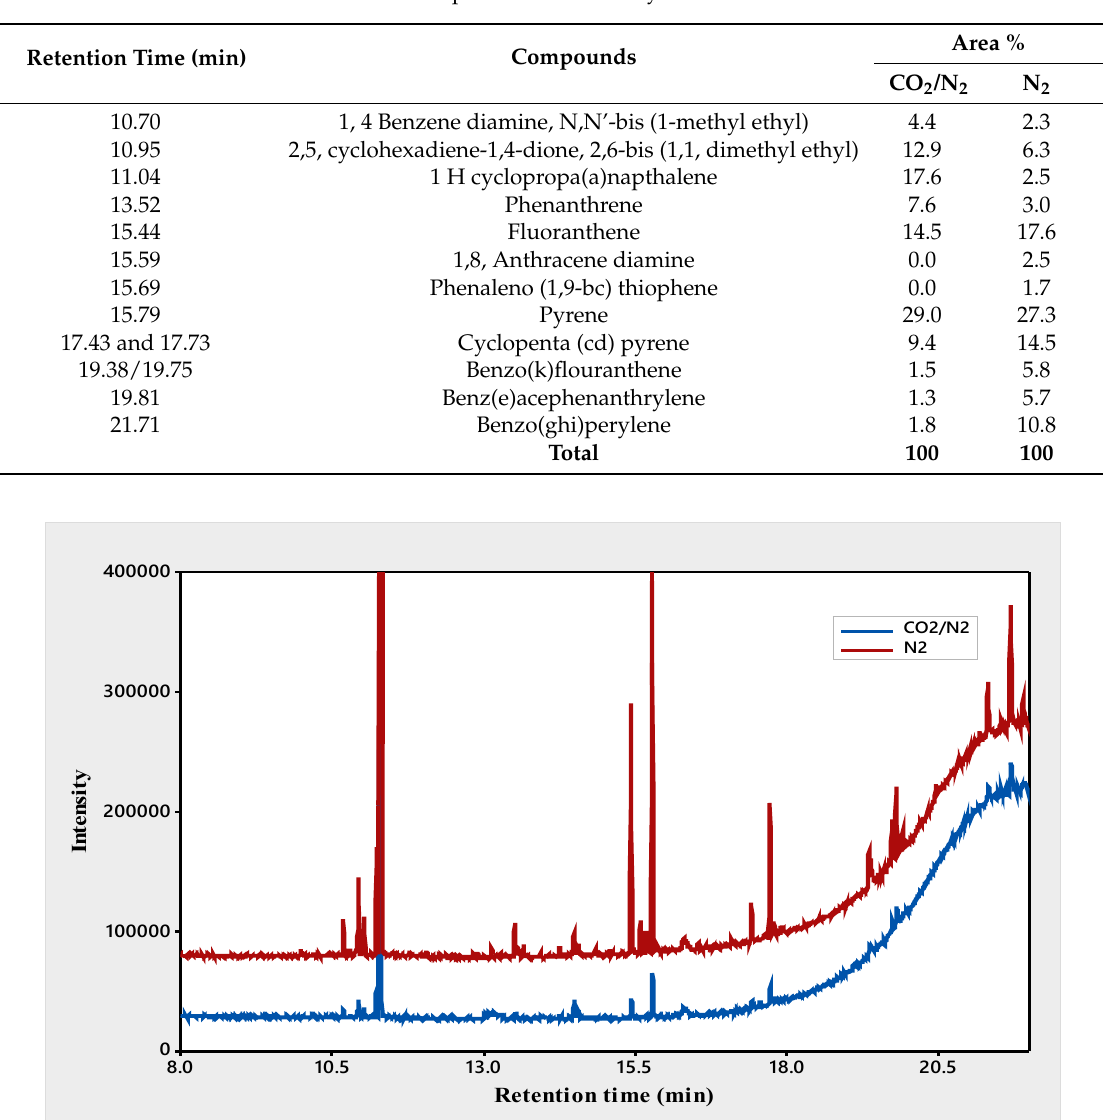
Figure 11 . GC-MS chromatograms of THF soluble tars obtained by washing chars generated in CO 2 /N 2 and N 2 atmospheres (only qualitative analysis).